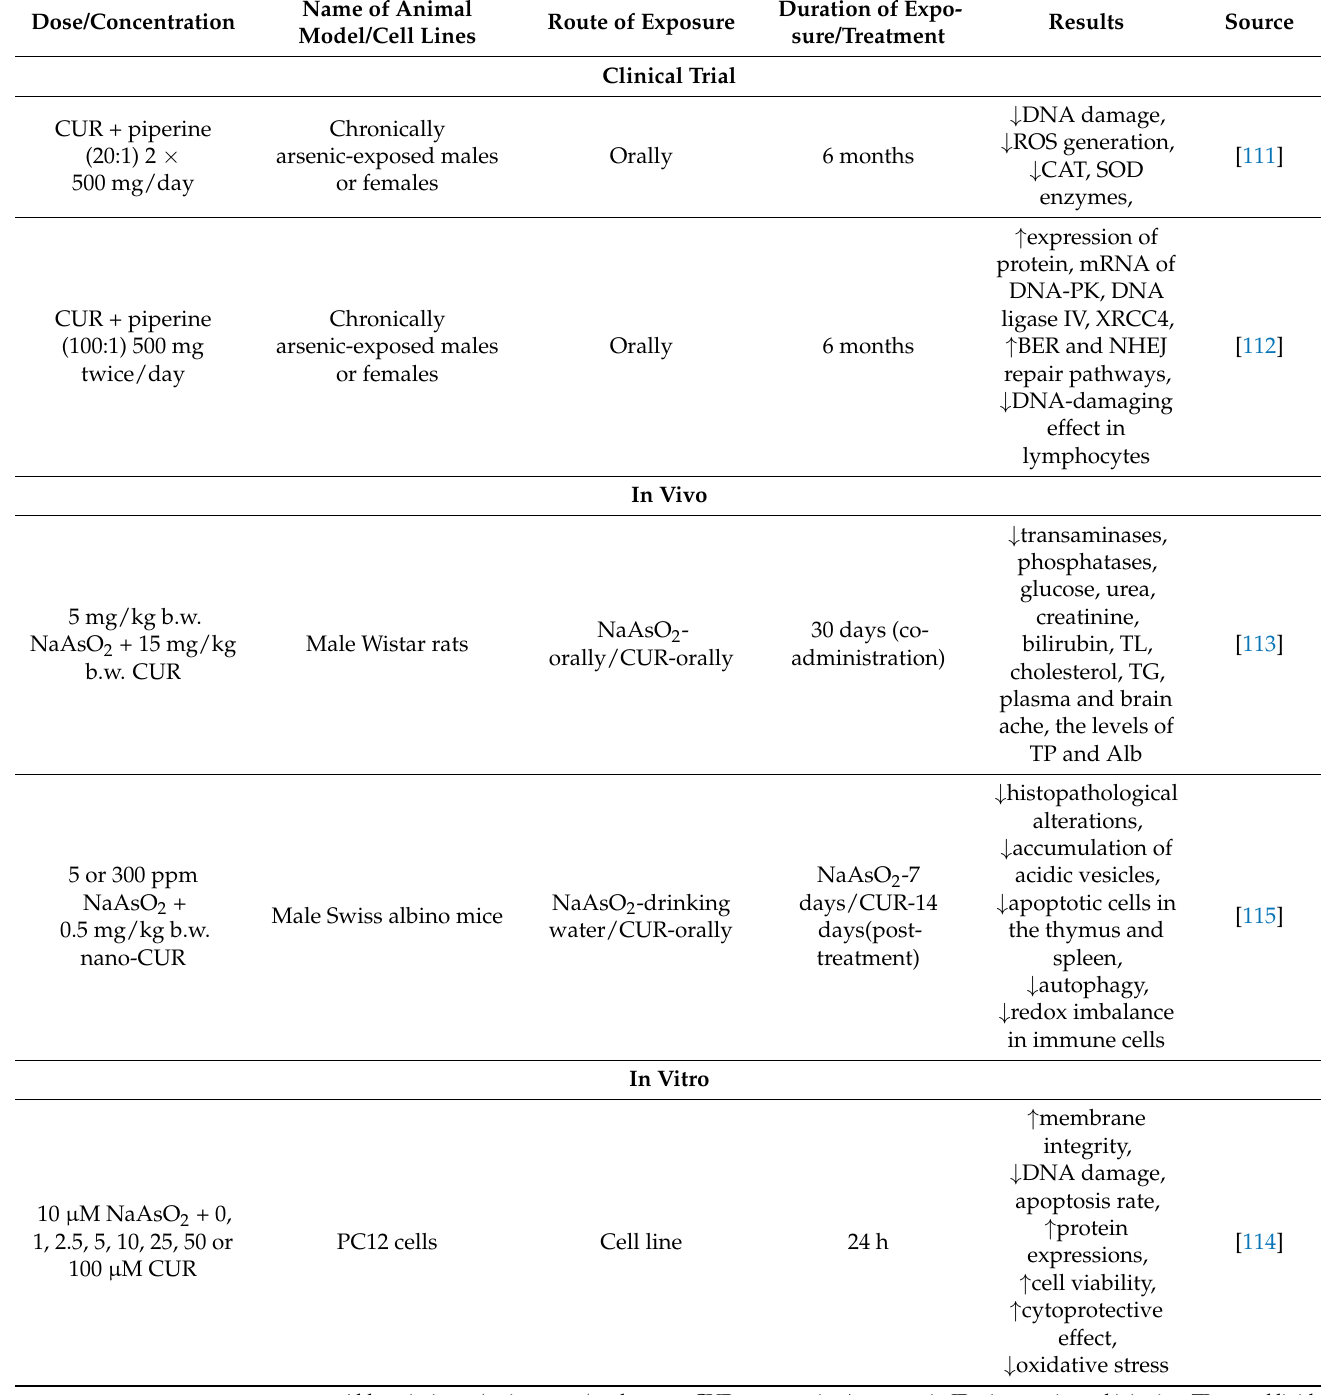
Table 3. Effects of curcumin on arsenic toxicity based on doses, experimental methods, and